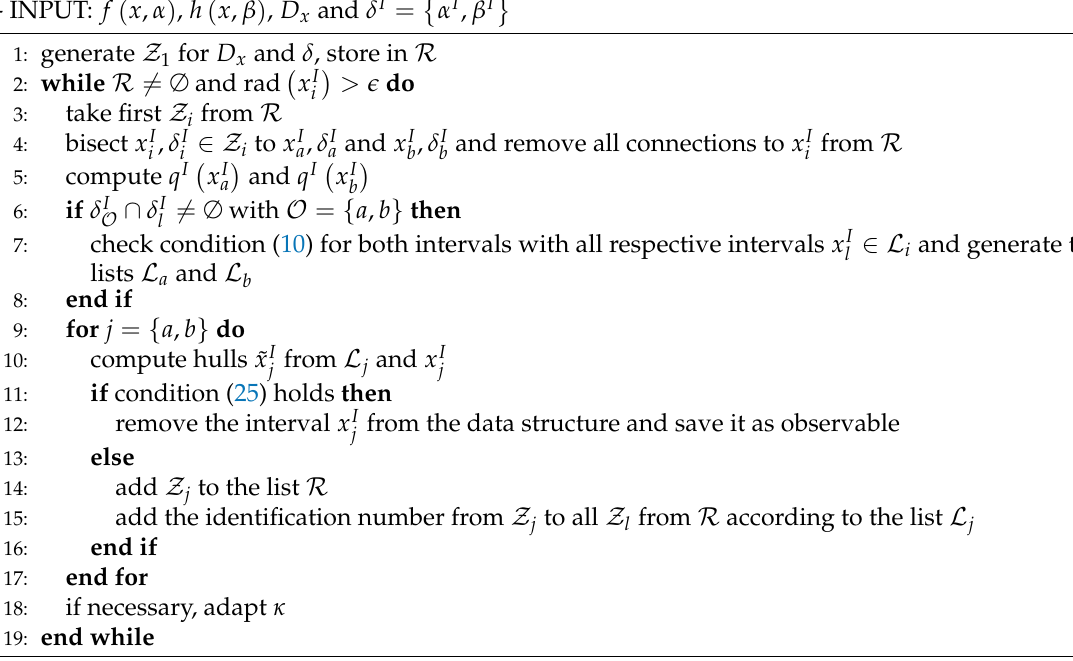
Algorithm 1 Robust